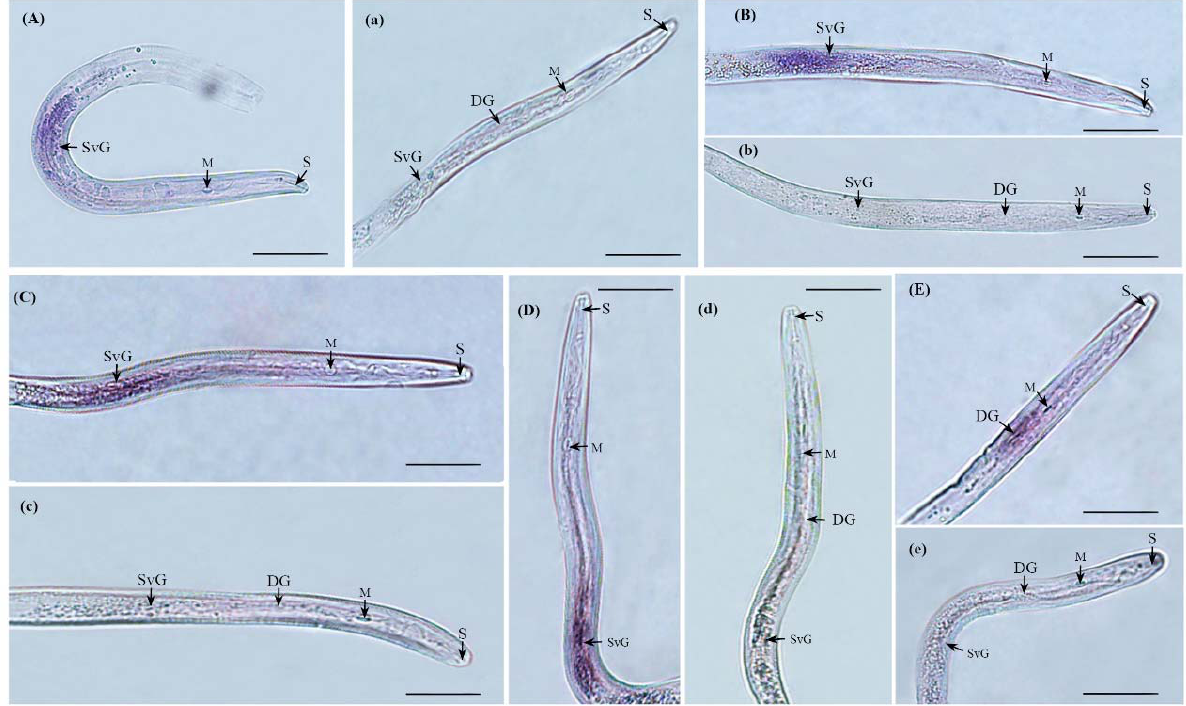
Figure 2. In situ hybridization of pre ‐ J2 of M. incognita . ( A – E ) indicate the location of secretion detected by MiCal , MiGST_N_4 , MiEFh , MiACPS , and MiTSPc antisense probes in second instar larval tissues of M. incognita , respectively. ( a – e ) indicate the detection of secretion location by MiCal , MiGST_N_4 , MiEFh , MiACPS , and MiTSPc sense probes, respectively. Hybridization signals for all effectors were observed at the same secretory sites in at least 3–5 nematodes, and we showed one of the nematodes with hybridization signals for all effectors. Subventral oesophageal glands (SvG) and dorsal esophageal gland (DG), metacorpus (M), and stylet (S) are indicated with arrows. Scale bars, 50 μ m.